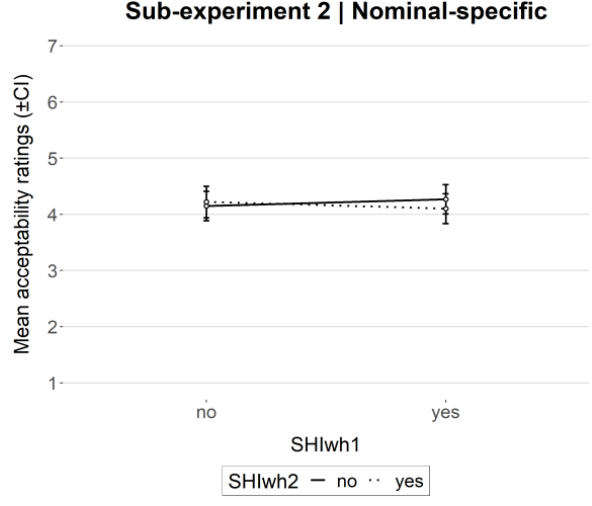
Figure 2. Mean acceptability ratings (n = 27). Error bars show 95% confidence interval.